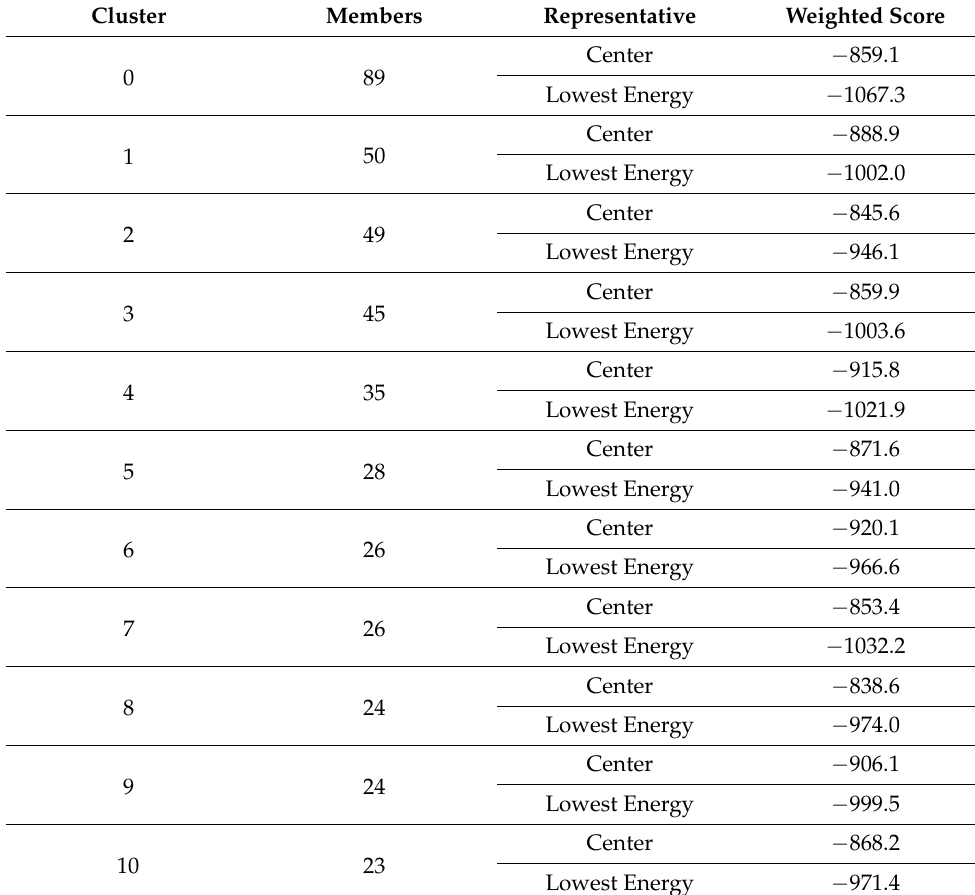
Table 8. Docking score of vaccine-TLR-4